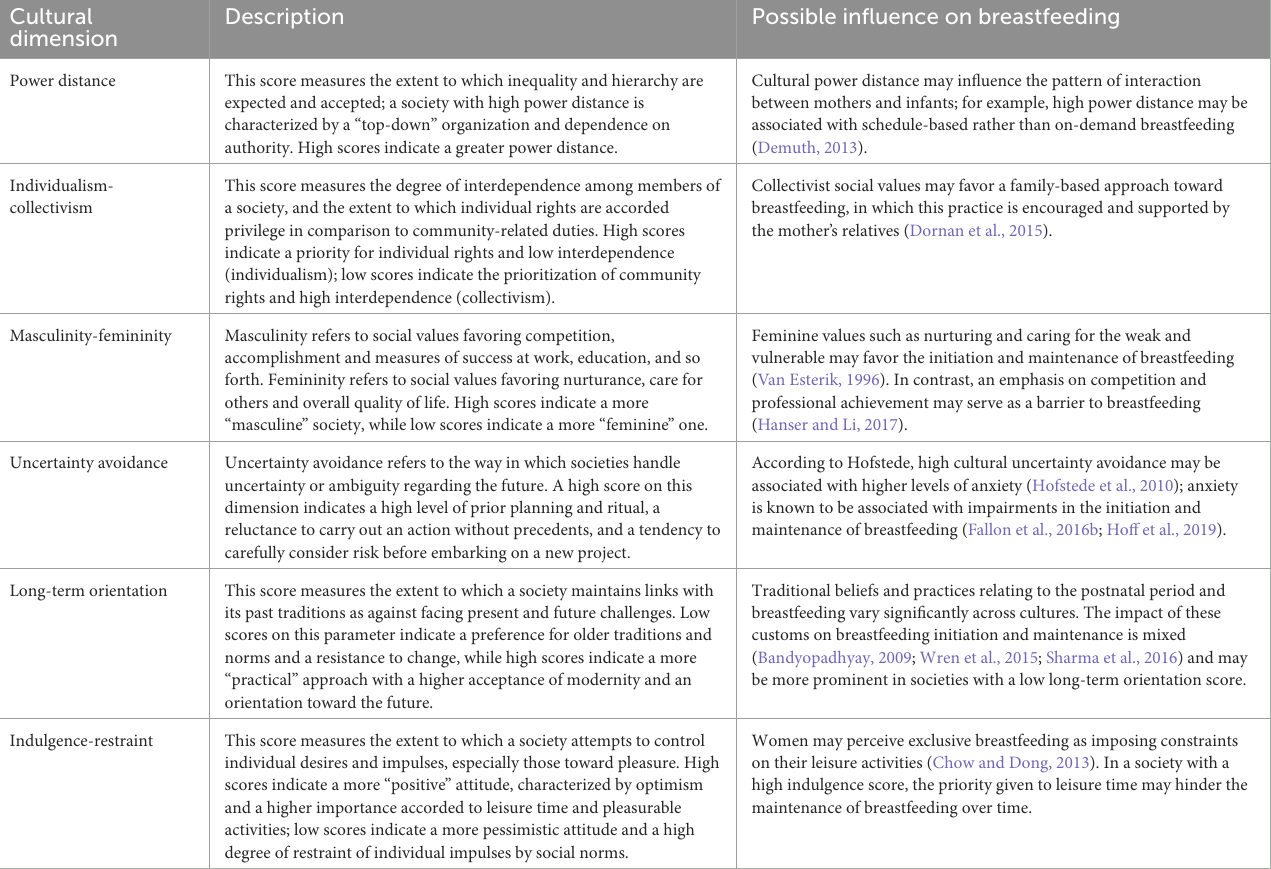
TABLE 1 Description of Hofstede’s cultural value dimensions and their potential relevance to breastfeeding initiation and maintenance.